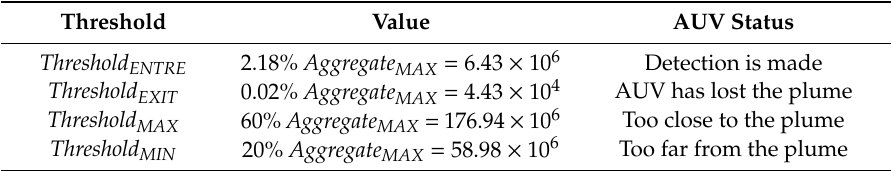
Table 2. Descriptions of thresholds set for detection